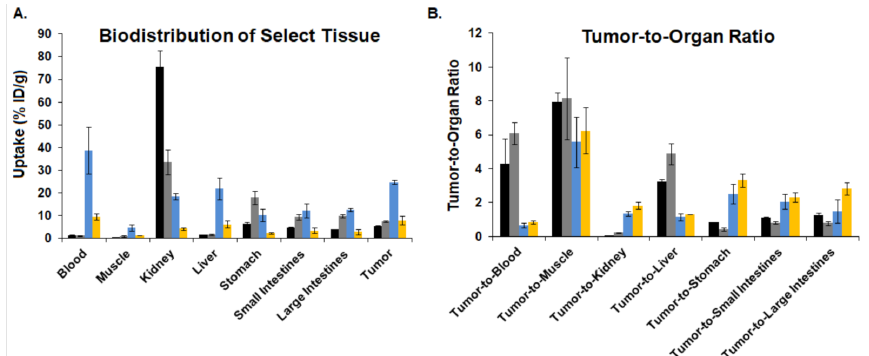
Figure 3. ( A ) Binding to human and mouse serum ( n = 3/compound/condition; bars: SD). ( B ) Stabil- Figure 5. ( A ) Biodistribution of select tissues at 4 h p.i. for [ 64 Cu] 1 – 4 . ( B ) Tumor-to-organ ratios at 4 ity in human serum at 37 °C. ( C ) Stability in mouse serum at 37 °C for [ 64 Cu] 1 ( ■ ) and [ 64 Cu] 2 ( ■ ). h p.i. for [ 64 Cu] 1 – 4 [ 64 Cu] 1 ( (cid:4) ), [ 64 Cu] 2 (